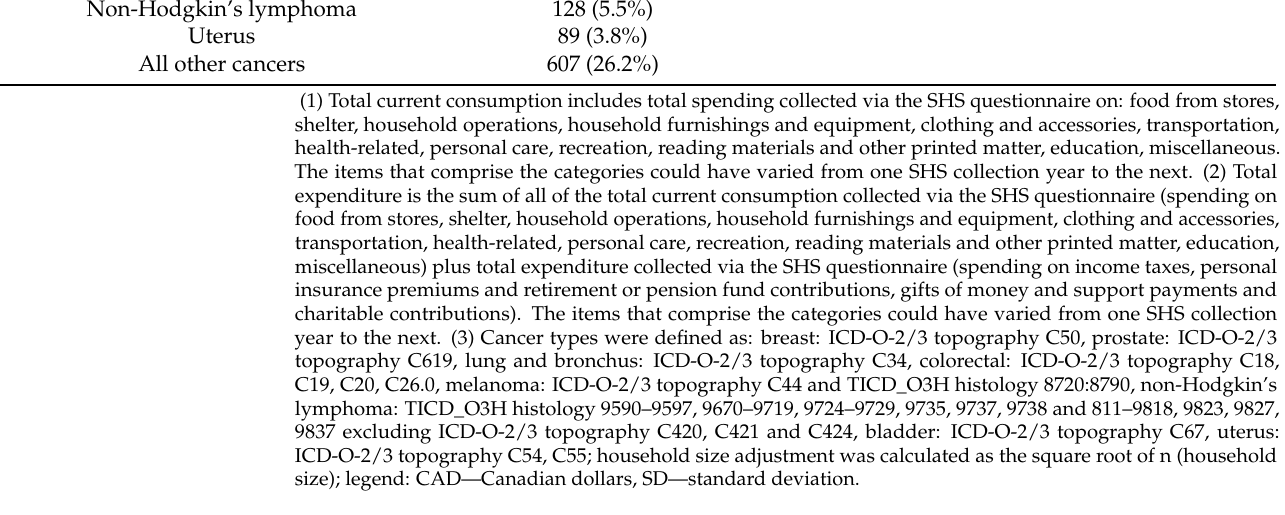
Households with Cancer (Cases)